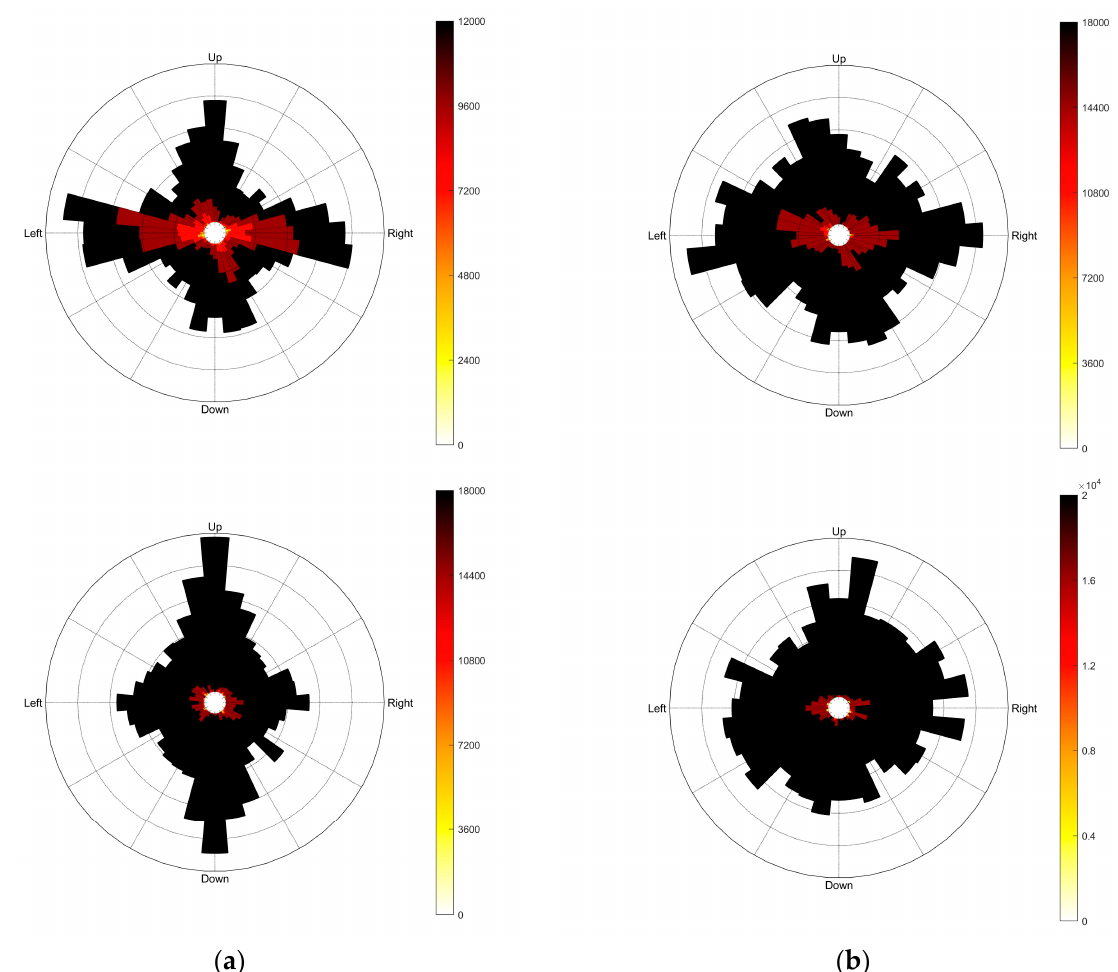
Figure 10. Rose plots of individual subject showing the efficiency of execution of gaze-controlled tasks during the game. The game requires the player to move their gaze horizontally and vertically. Moves in other directions represents error due to fatigue or lack of training. ( a ) Start of the game. ( b ) End of the game.